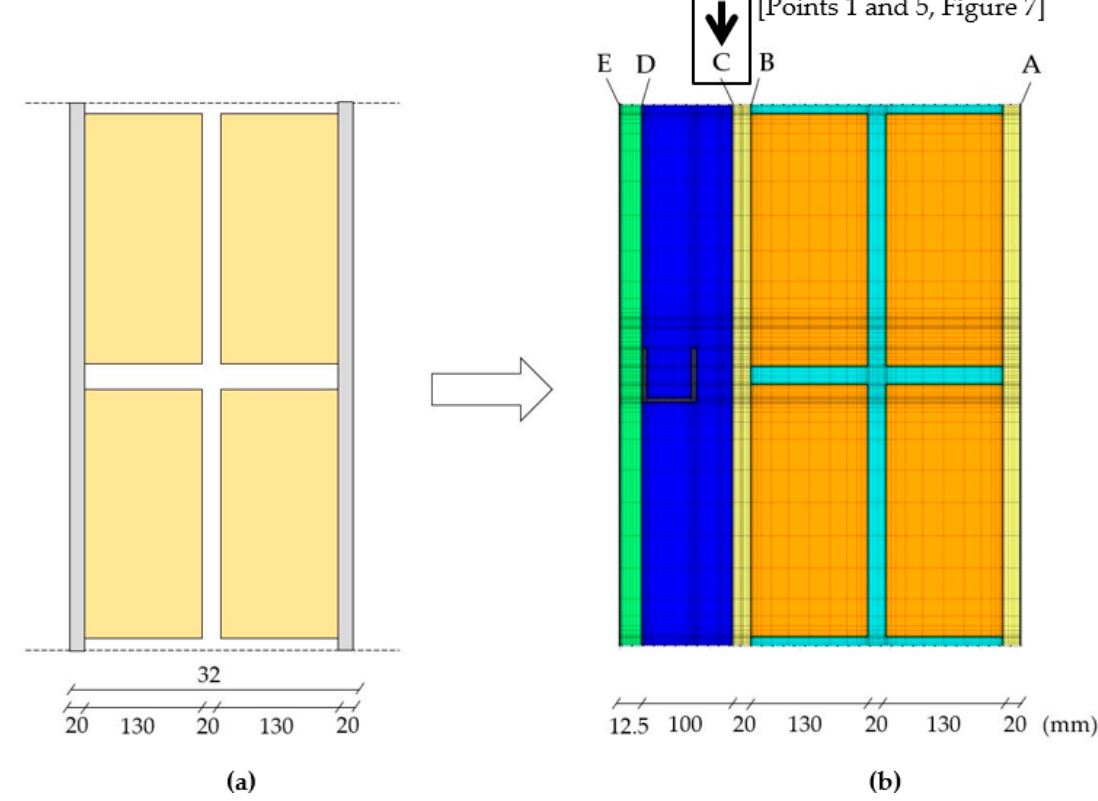
Figure 9. Two-dimensional model deducted for the dynamic simulation.